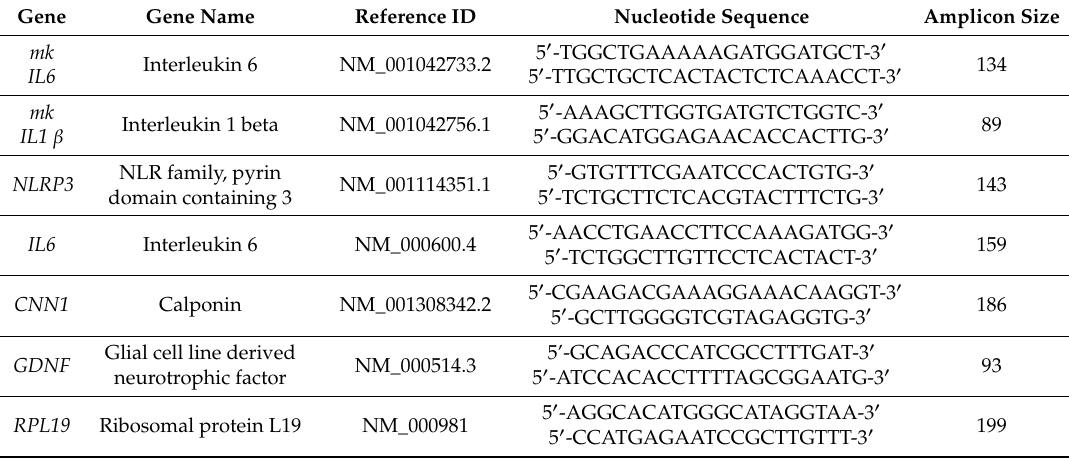
Table 1. Nucleotide sequence of primers (Gene and gene name) employed in real time PCR including amplicon size and reference